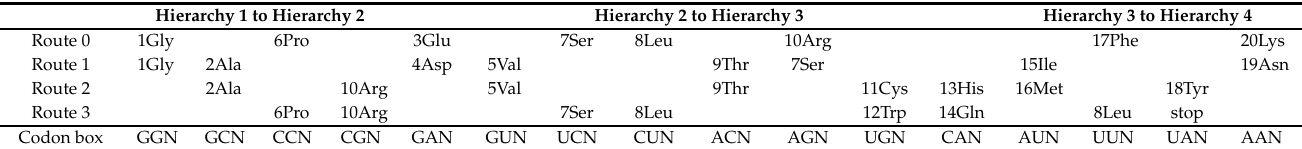
Table 2. Formation of the codon boxes via (quasi) route